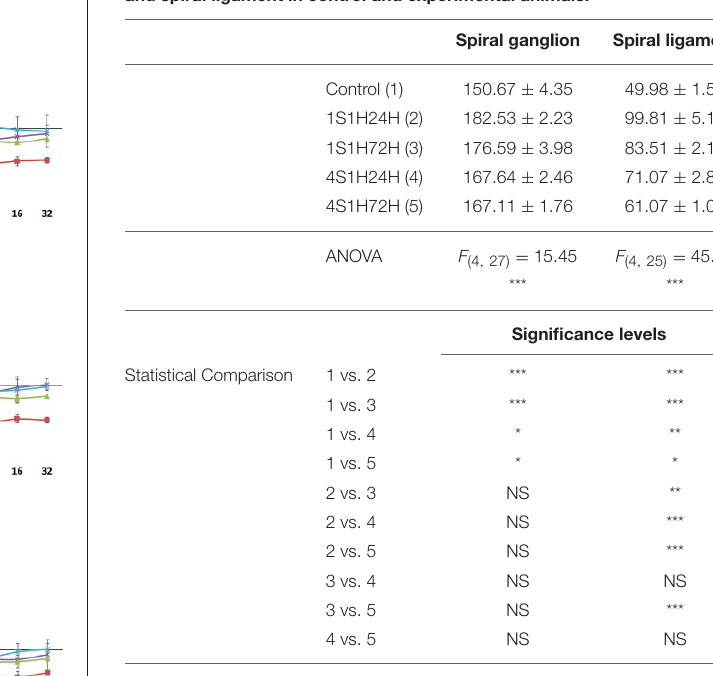
TABLE 5 | Mean gray level of CR immunostaining in the spiral ganglion and spiral ligament in control and experimental